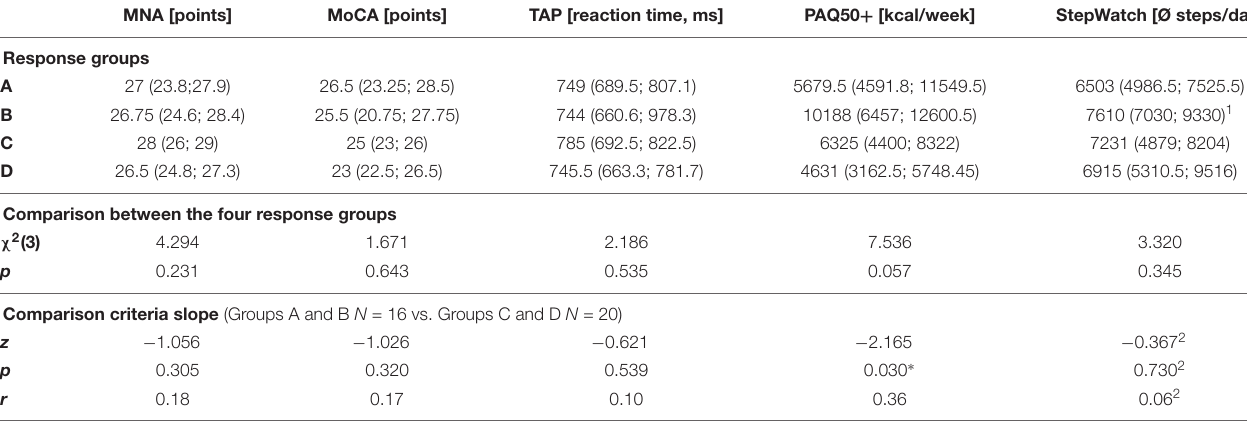
TABLE 3 | Comparison of physical activity, nutritional status, and cognition between the different response groups. MNA [points] MoCA [points] TAP [reaction time, ms] PAQ50 + [kcal/week] StepWatch [Ø